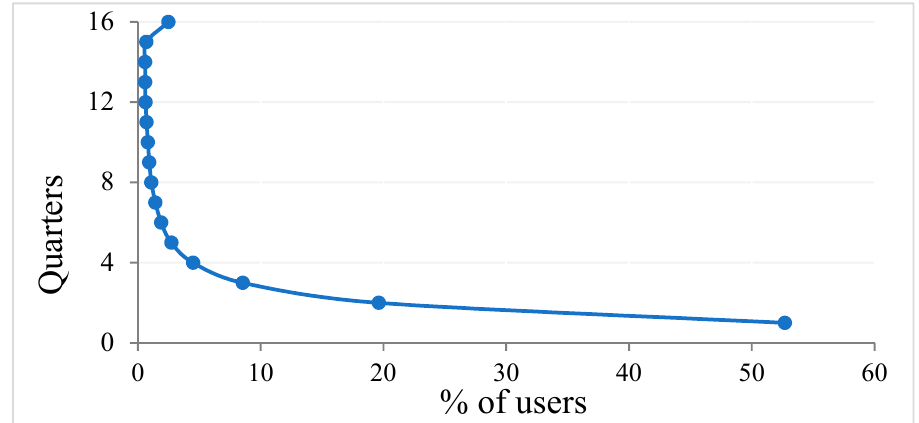
Figure 1. Distribution of users of prescription opioids and the duration of utilisation.